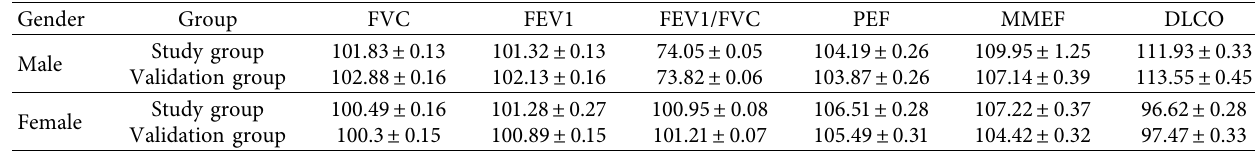
Table 5: Normal lung function values calculated for adults in Zhejiang